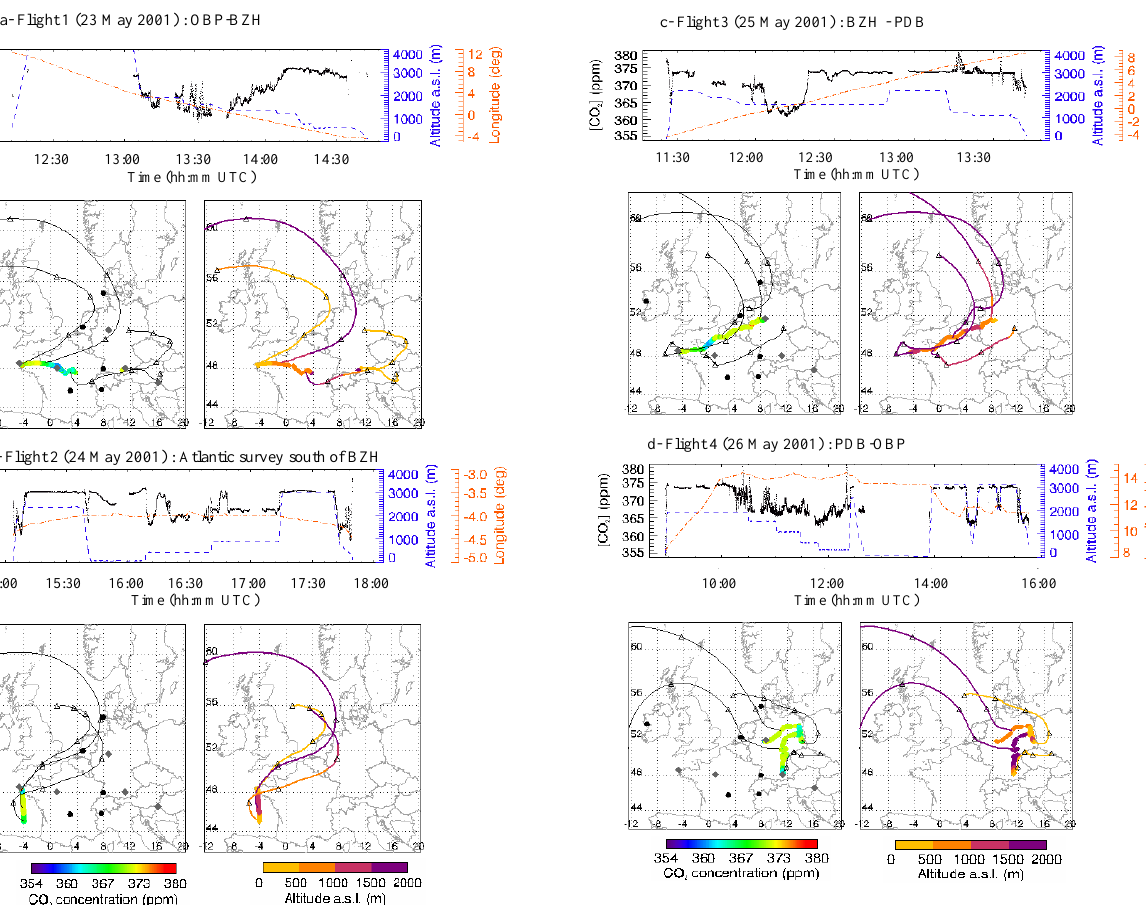
Fig. 5. (a, b) Back-trajectories computed over 96h for flight 1 and flight 2. The distance between 2 triangles is 24h. Left panels show CO 2 concentrations along the flight path and back- trajectories. Right panels show the altitude of the flight, and back- trajectories colored according to air mass altitude. Black circles rep- resent ground stations named in Fig. 1. Altitude is given in meters above the sea level (m a.s.l.). Note that some of the back-trajectories are outside the latitude and longitude chosen borders, but these are so diluted that they do not give any relevant information.